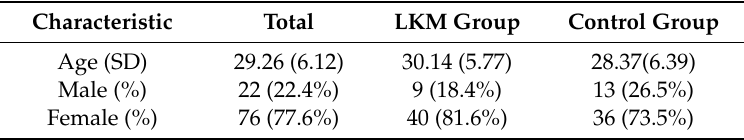
Table 1. Demographic characteristics of